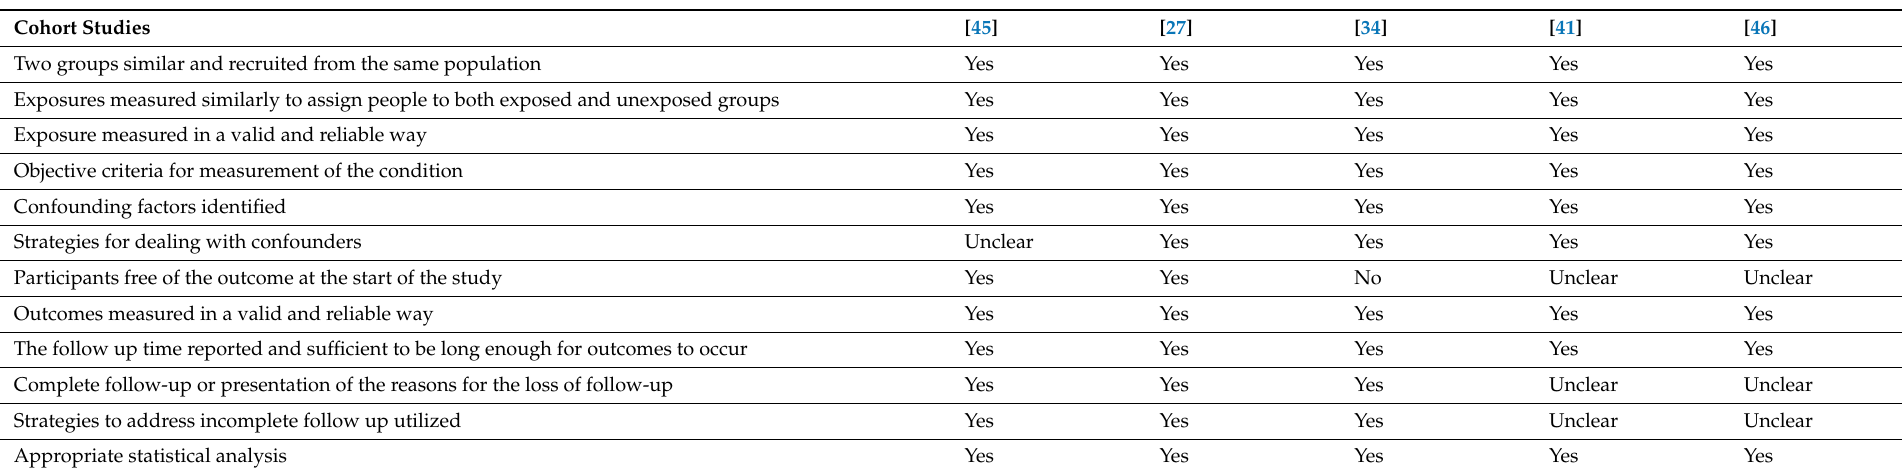
Table 3. Critical appraisal of the included studies—cohort